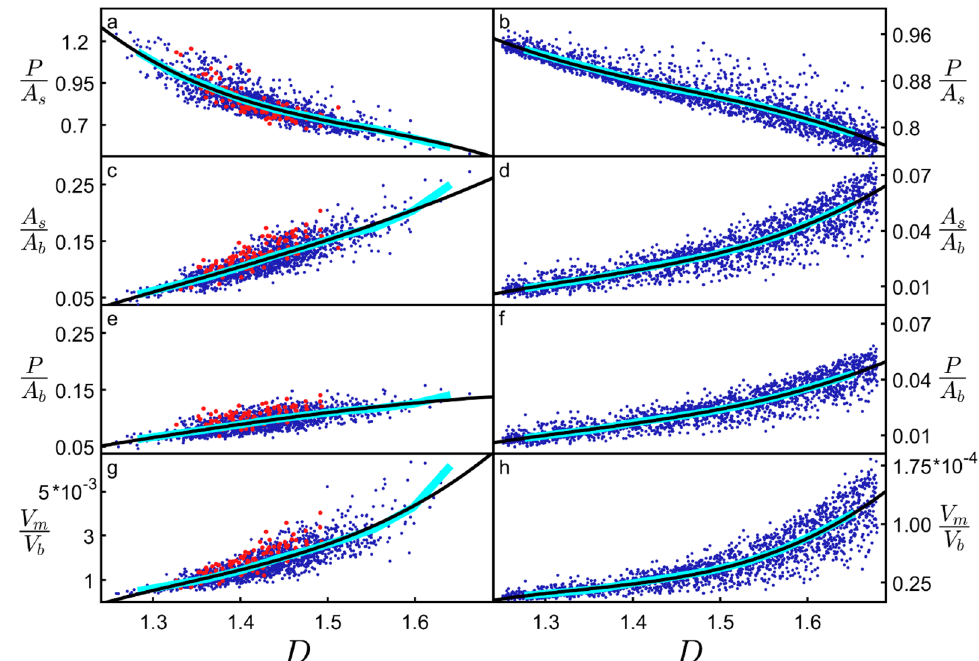
Figure 4. Dependences of various parameters (see text for parameter definitions) on D for neurons (left column) and H-Trees (right column). Red data are for unmanipulated basal arbors while the blue data are for basal arbors where either their θ or values are manipulated. H-Trees with straight and with weaving branches are included. The cyan lines correspond with binned averages of the plots while the black curves correspond to ϕ 3rd degree polynomial fits to the